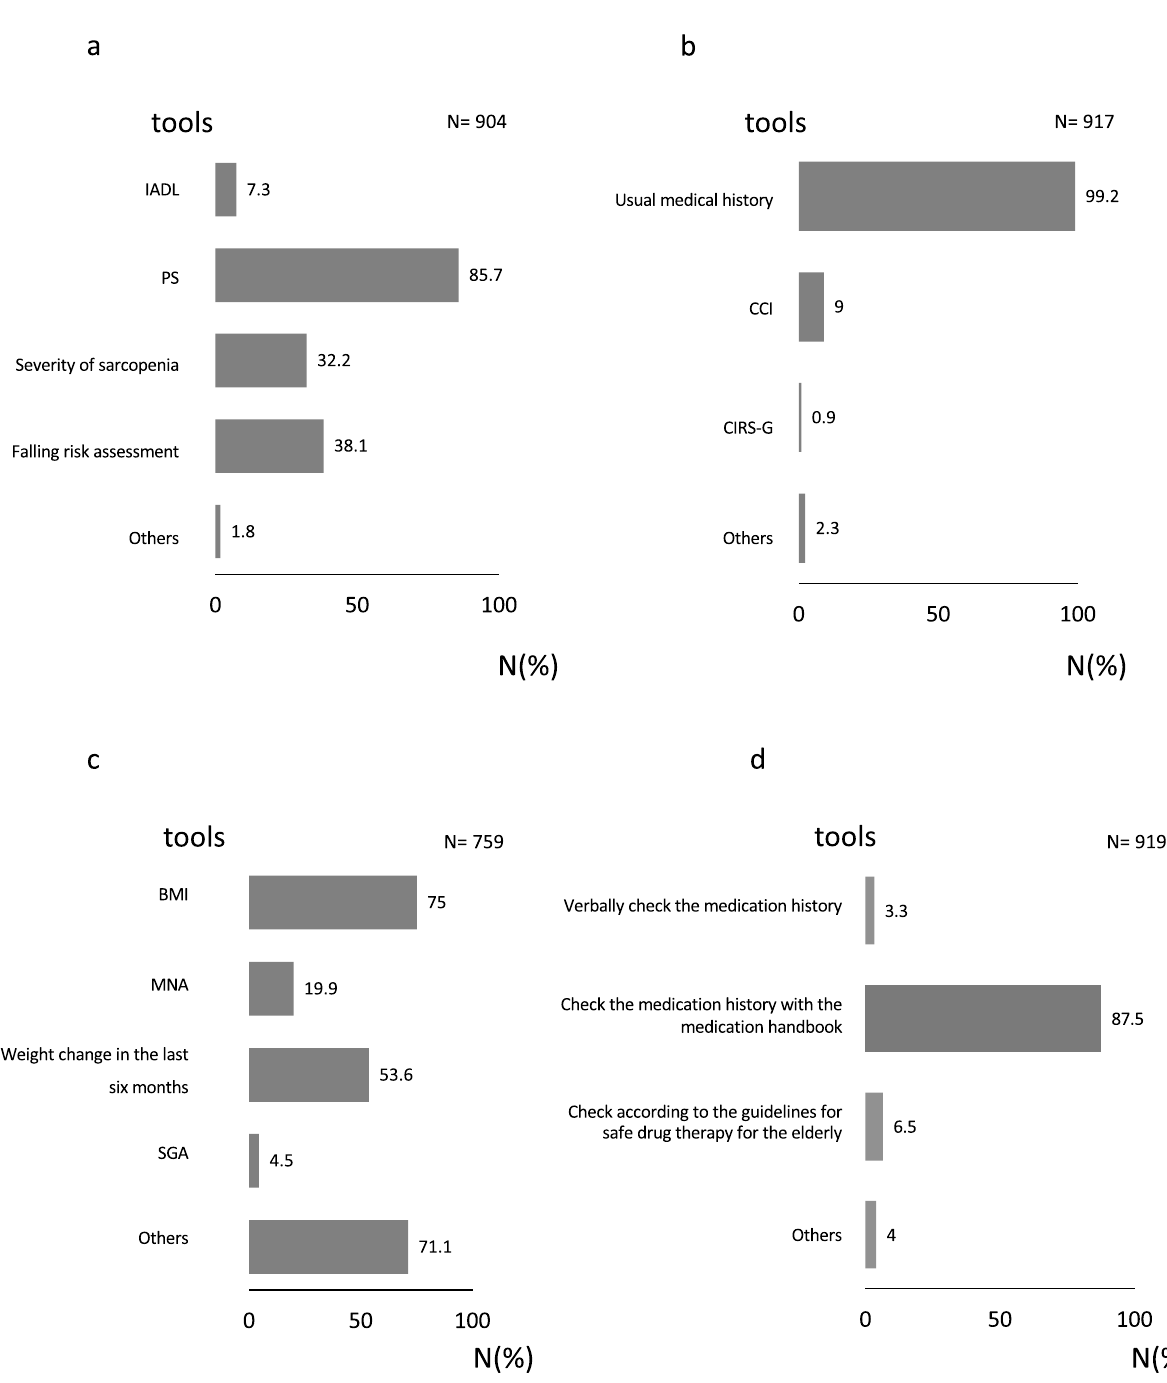
Figure 2. Evaluation tools for each preoperative evaluation item. We asked about the detailed evaluation methods for each preoperative evaluation item. (Multiple responses accepted). ( a ) Do you use specific tools to check the physical condition of patients before surgical treatment? ( b ) Do you use specific tools to check the complication status of patients before surgical treatment? ( c ) Do you use specific tools to check the nutritional status of patients before surgical treatment? ( d ) Do you use specific tools to check the medication status of patients before surgical treatment? ( e ) Do you use specific tools to check the cognitive status of patients before surgical treatment? ( f ) Do you use specific tools to check the mood of patients before surgical treatment? ( g ) Do you use specific tools to check the social support status of patients before surgical treatment? ( h ) Do you use specific tools to confirm the predicted disease onset before surgical treatment? IADL instrumental activities of daily living, PS performance status, CCI Charlson comorbidity index, CIRS-G cumulative illness rating scale-geriatric, BMI body mass index, MNA mini nutritional assessment, SGA subjective comprehensive assessment, HDS-R Hasegawa’s dementia scale-revised; MMSE mini-mental state examination; GDS-15 geriatric depression scale-15; PHQ-9 patient health questionnaire 9; LSNS-6 Lubben social network scale-6; MOS medical outcomes study; JNS Japanese version of the NEECHAM confusion scale; DST delirium screening tool; ICDSC intensive care delirium screening checklist; MDAS memorial delirium assessment